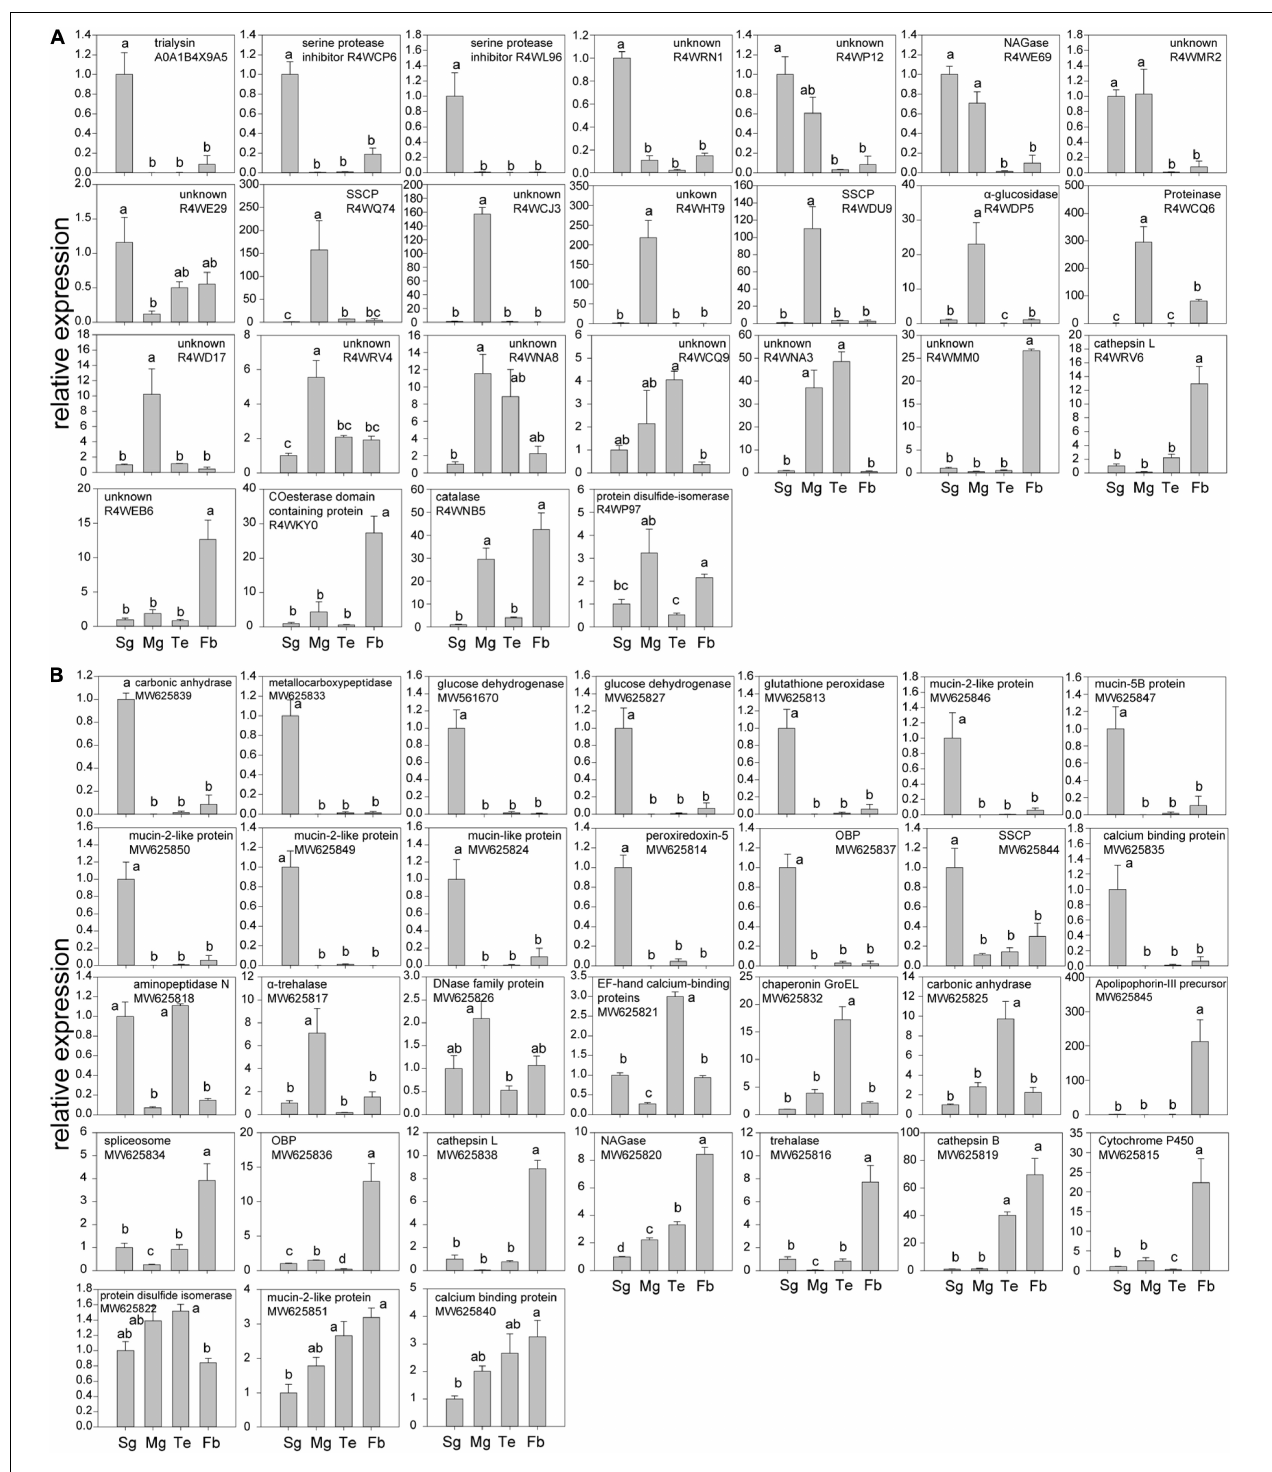
FIGURE 2 | RT-qPCR testing the tissue-specific expression of genes in salivary glands (Sg), mid-guts (Mg), testes (Te), and fat bodies (Fb) of R. pedestris males. (A) Expression levels of genes that encoded proteins found in male saliva; (B) genes that were selected from the transcriptome of salivary glands. The graphs were shown as: first are genes that are highly expressed in salivary glands, then those that are abundantly produced by mid-guts, testes, or fat bodies. In addition, the expression levels of another 12 genes (6 from the transcriptome and 6 found in saliva) were not biased to a tested tissue and their data were shown in Supplementary Table 4 . Different lowercase letters above the bars indicate that there are significant differences ( P ≤ 0.05).